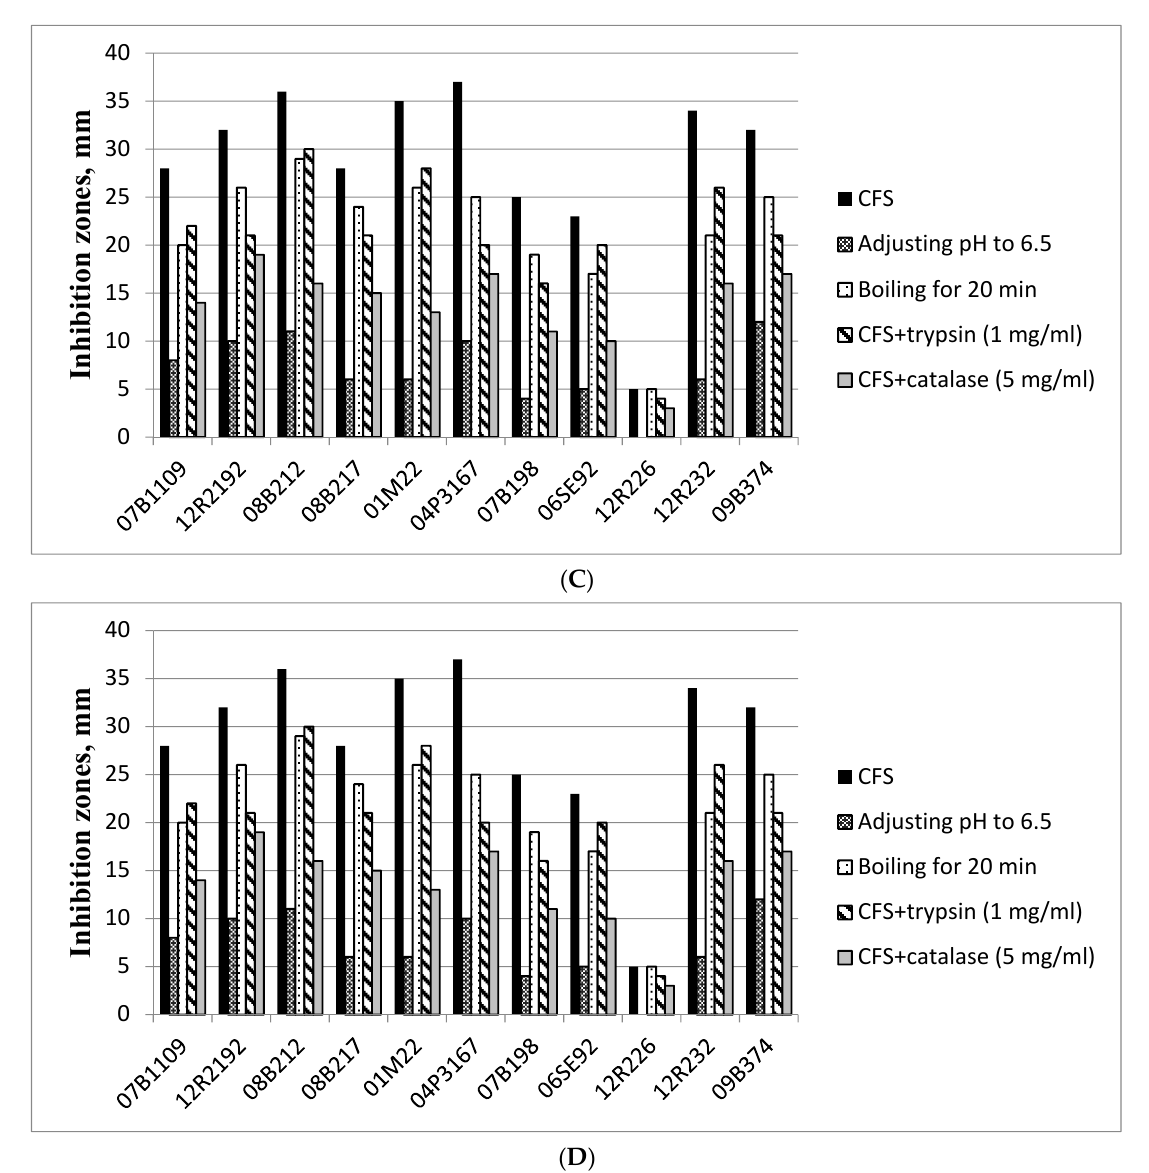
Figure 2. Antifungal activity of selected LAB from Bulgarian sourdoughs against Penicillium chrysogenum NBIMCC 129 ( A ), Fusarium graminearum NBIMCC 2294 ( B ), Rhizopus stolonifer NBIMCC 130 ( C ) and Aspergillus nidulans NBIMCC 116 ( D ).